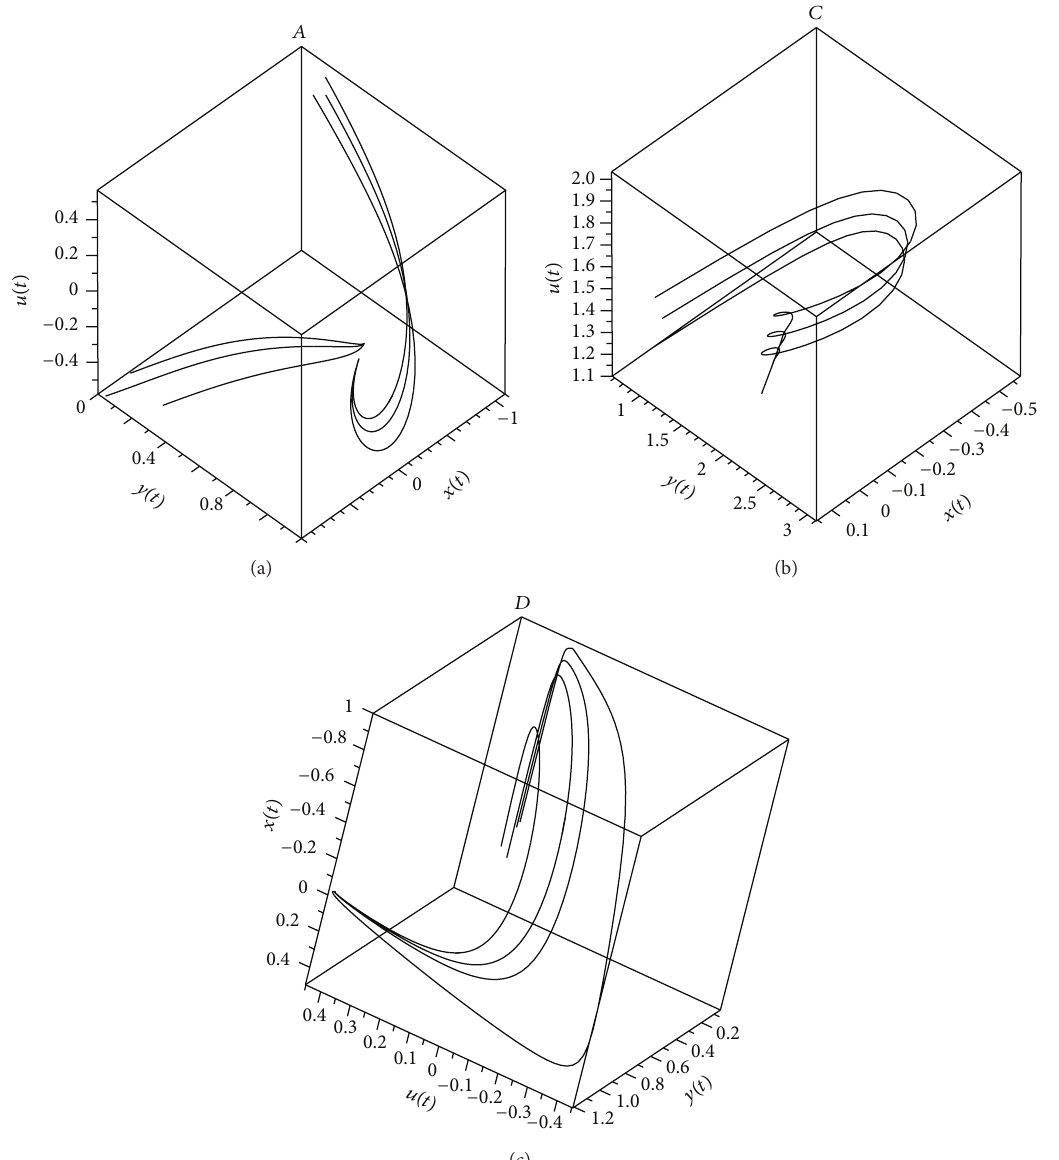
Figure 4: Three-dimensional phase-space trajectories of the model with stable attractors 𝐴 (a), 𝐶 (b), and 𝐷 (c), respectively.